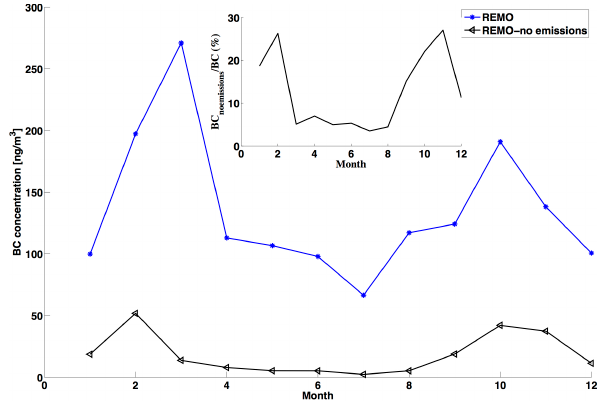
Fig. 16. Comparison of the monthly modelled median BC concen- trations: blue stars: the full emissions run; black triangles: the model results when the BC emissions in Finland are switched off. The in- side plot represents the percentage of the BC concentrations from the no-emissions run from the full-emissions